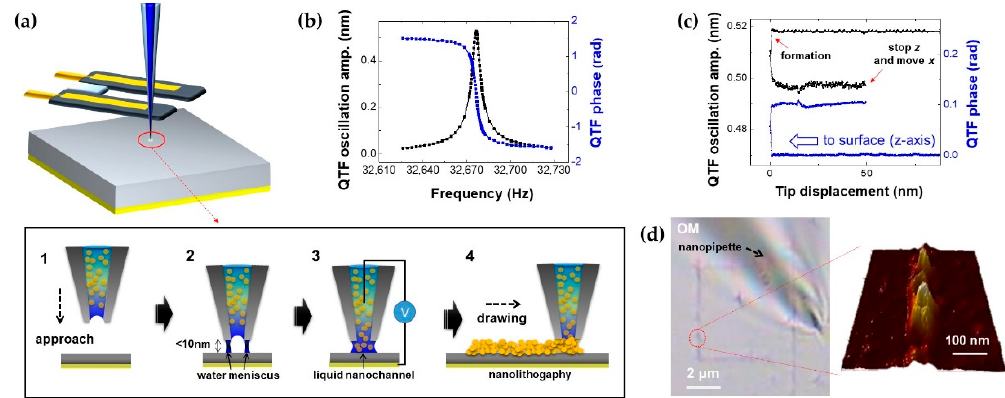
Figure 4. Nanolithography via nanopipette/QTF–AFM. ( a ) Schematic and procedure of experiment: (1) Tip approaching, (2) formation of nanoscale water meniscus between the rim of the tip apex and the substrate, (3) nanomeniscus-based ejection of the Au nanoparticle solution at a voltage bias (~10 V) in ambient conditions forming liquid nanochannel, (4) nanolithography by lateral movement of the tip as drawing. ( b ) Resonance curve of the QTF sensor with high Q-factor (~6000). ( c ) Approach/retraction curve for experimental procedure. ( d ) Nanolithography result (optical microscope (OM) image and AFM scanned image) with less than 100 nm linewidth with 30 nm aperture nanopipette.